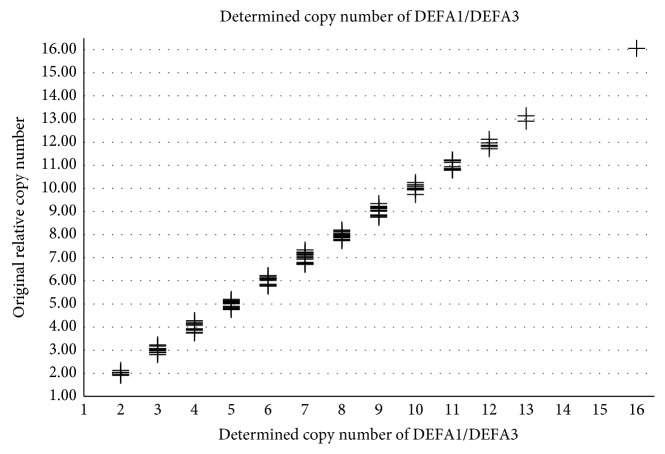
The determined copy number and its original relative copy number of DEFA1/DEFA3. The x-axis referred to the finally determined copy number, and the y-axis was the original relative copy number obtained from the qPCR method before rounding. The median CNV of a total of 215 critically ill patients was 7.